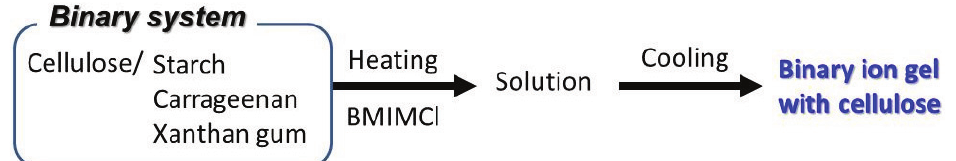
Figure 14. Procedure for fabrication of binary ion gels with BMIMCl.